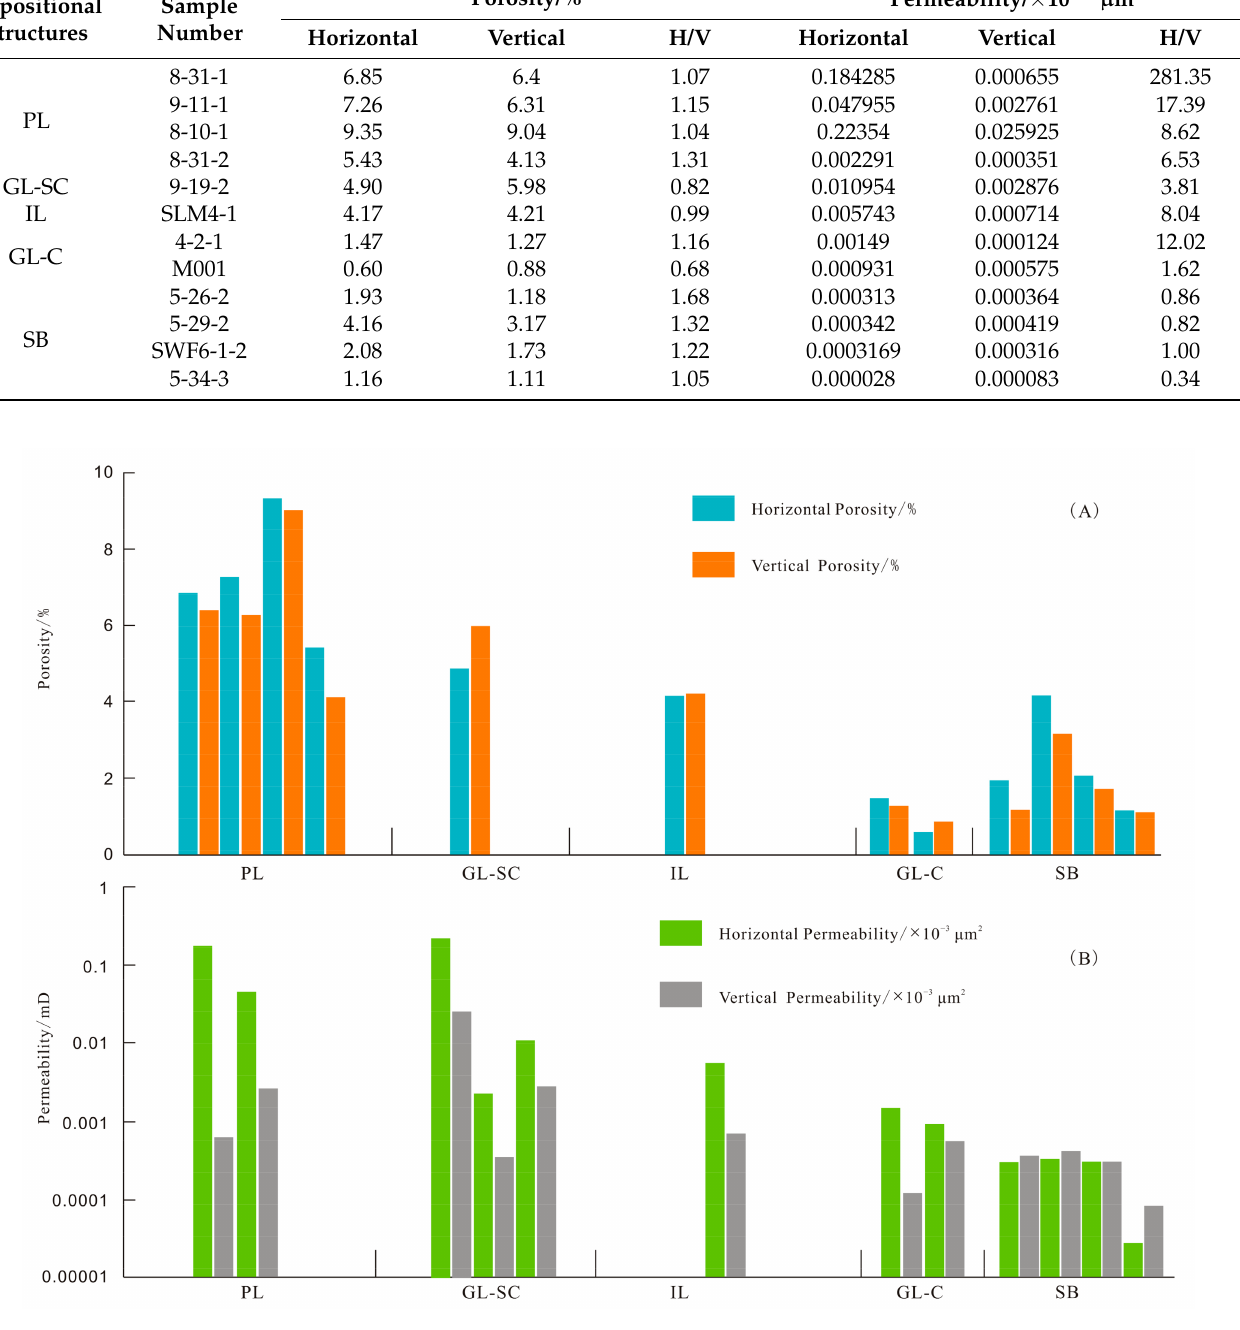
Figure 14. Porosity and permeability of different samples of the five lamination styles. ( A ) Horizontal and vertical porosity; ( B ) Horizontal and vertical